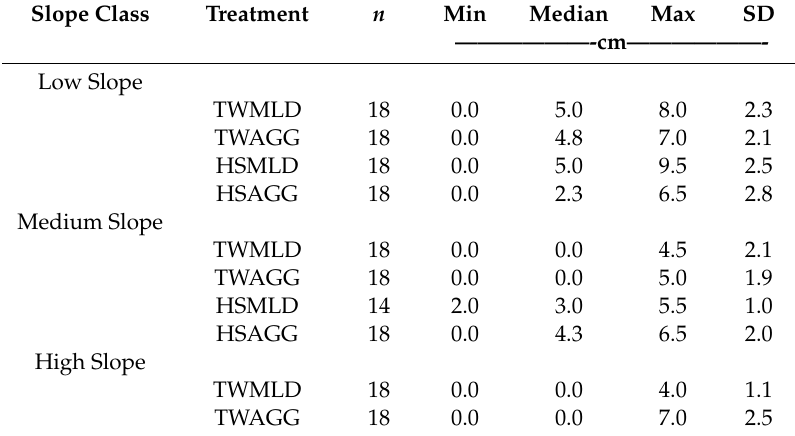
Figure 7. Photos of a harvest site depicting the low amount of rutting and overall soil disturbance observed as a result of the tethered logging operation. Table 3. Descriptive statistics for rut depth for all slope classes and treatments.